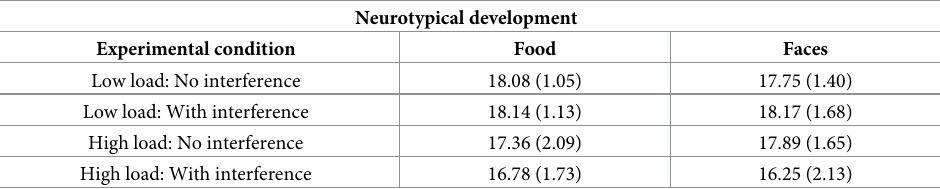
Table 6. Experimental task by material: Mean (standard deviation).